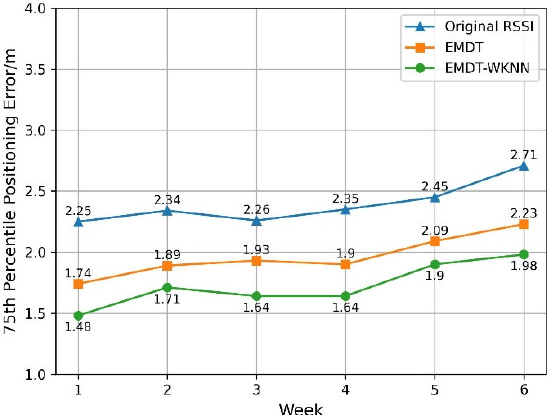
Figure 15. The 75th percentile positioning error for different weeks.